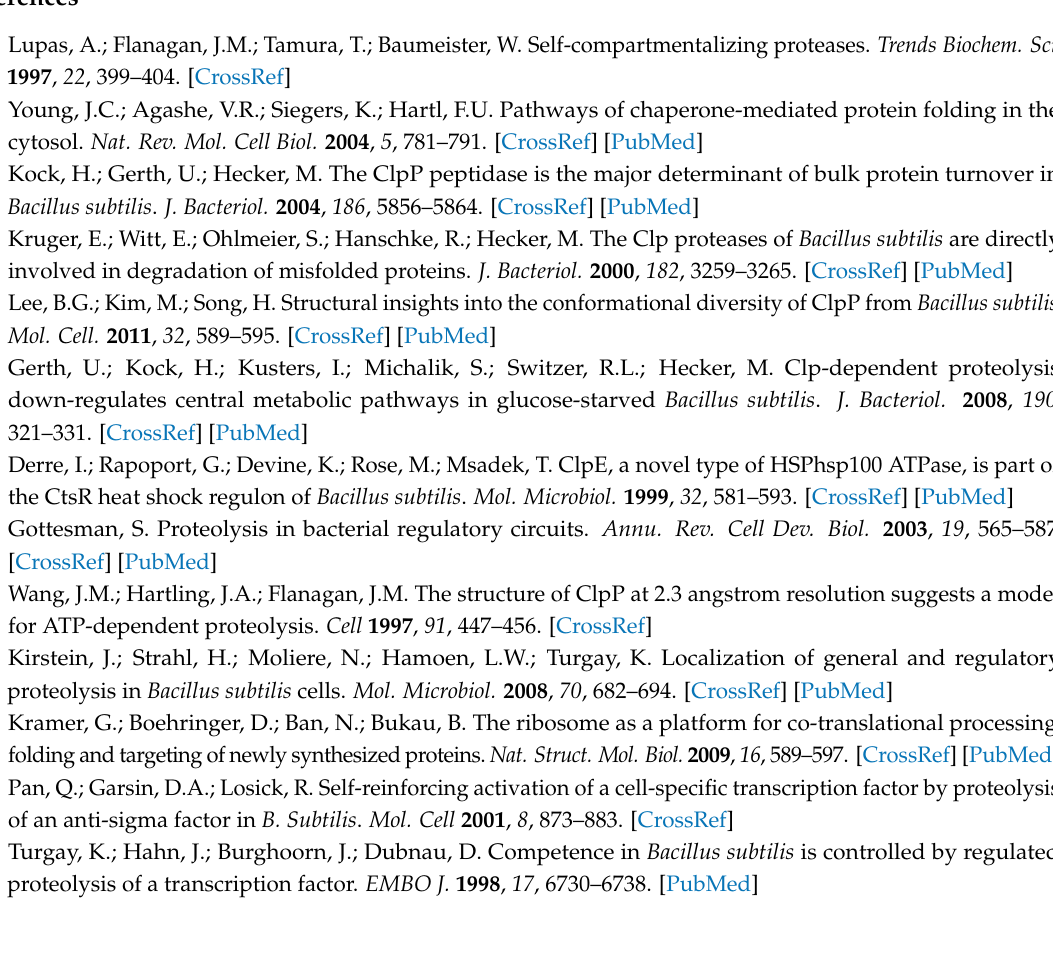
Figure S1: Growth curves of B. subtilis wild type (green solid line) and clpP mutant (red solid line) together with energy charge (dashed lines) of four biological replicates, Figure S2: Overview about cell length, Figure S3: Disk diffusion experiments using disks with 6 mm diameter, Table S1: List of detected and altered metabolites with their corresponding proteins known as ClpP substrates in the clpP mutant in comparison to the wild